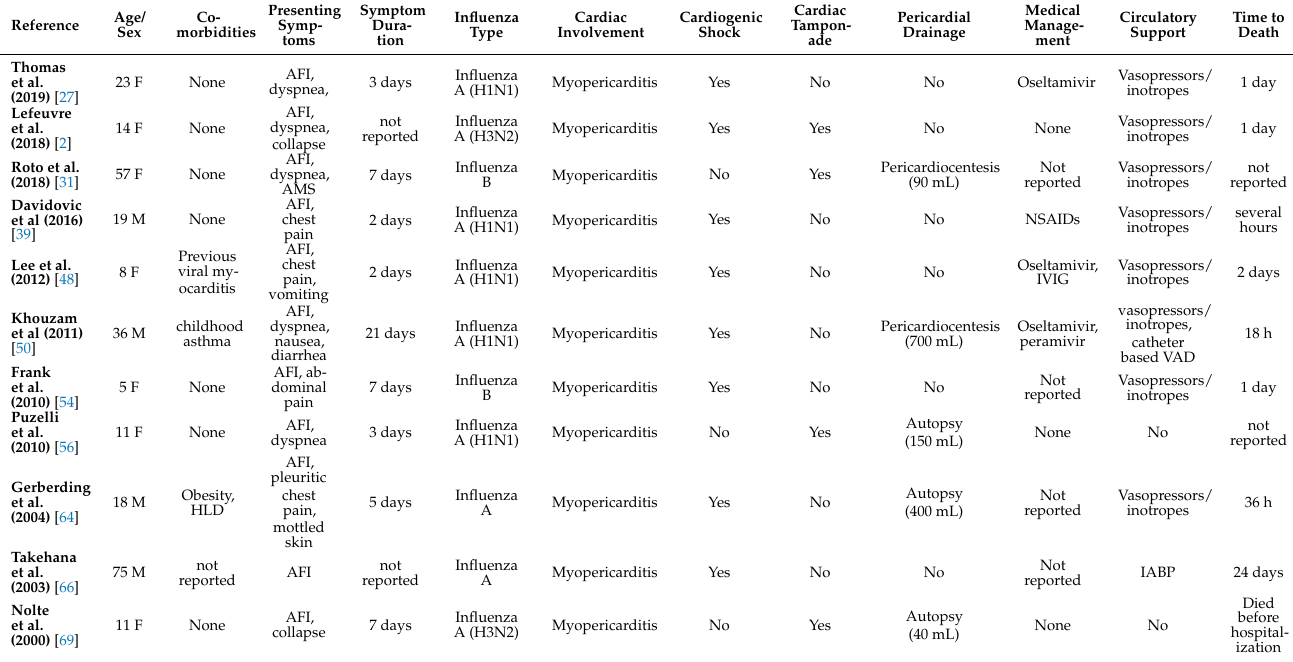
Table 4. Fatal influenza myopericarditis cases.